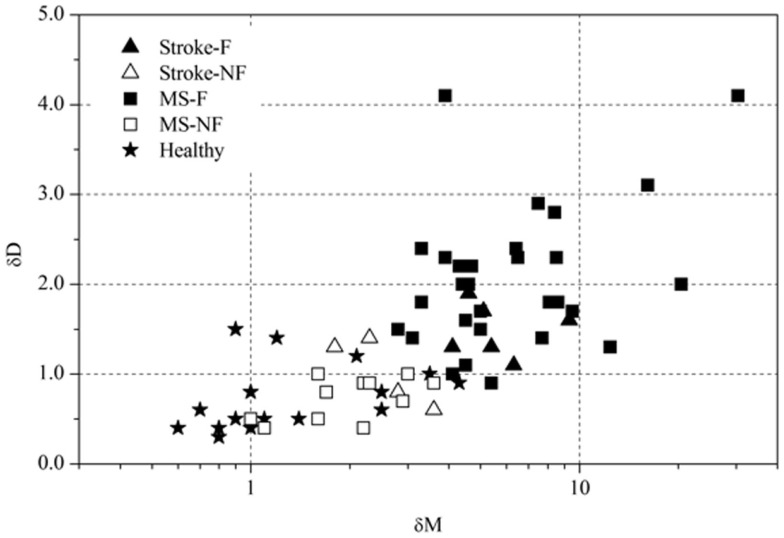
Scatterplot between changes in movement pattern and movement variability.